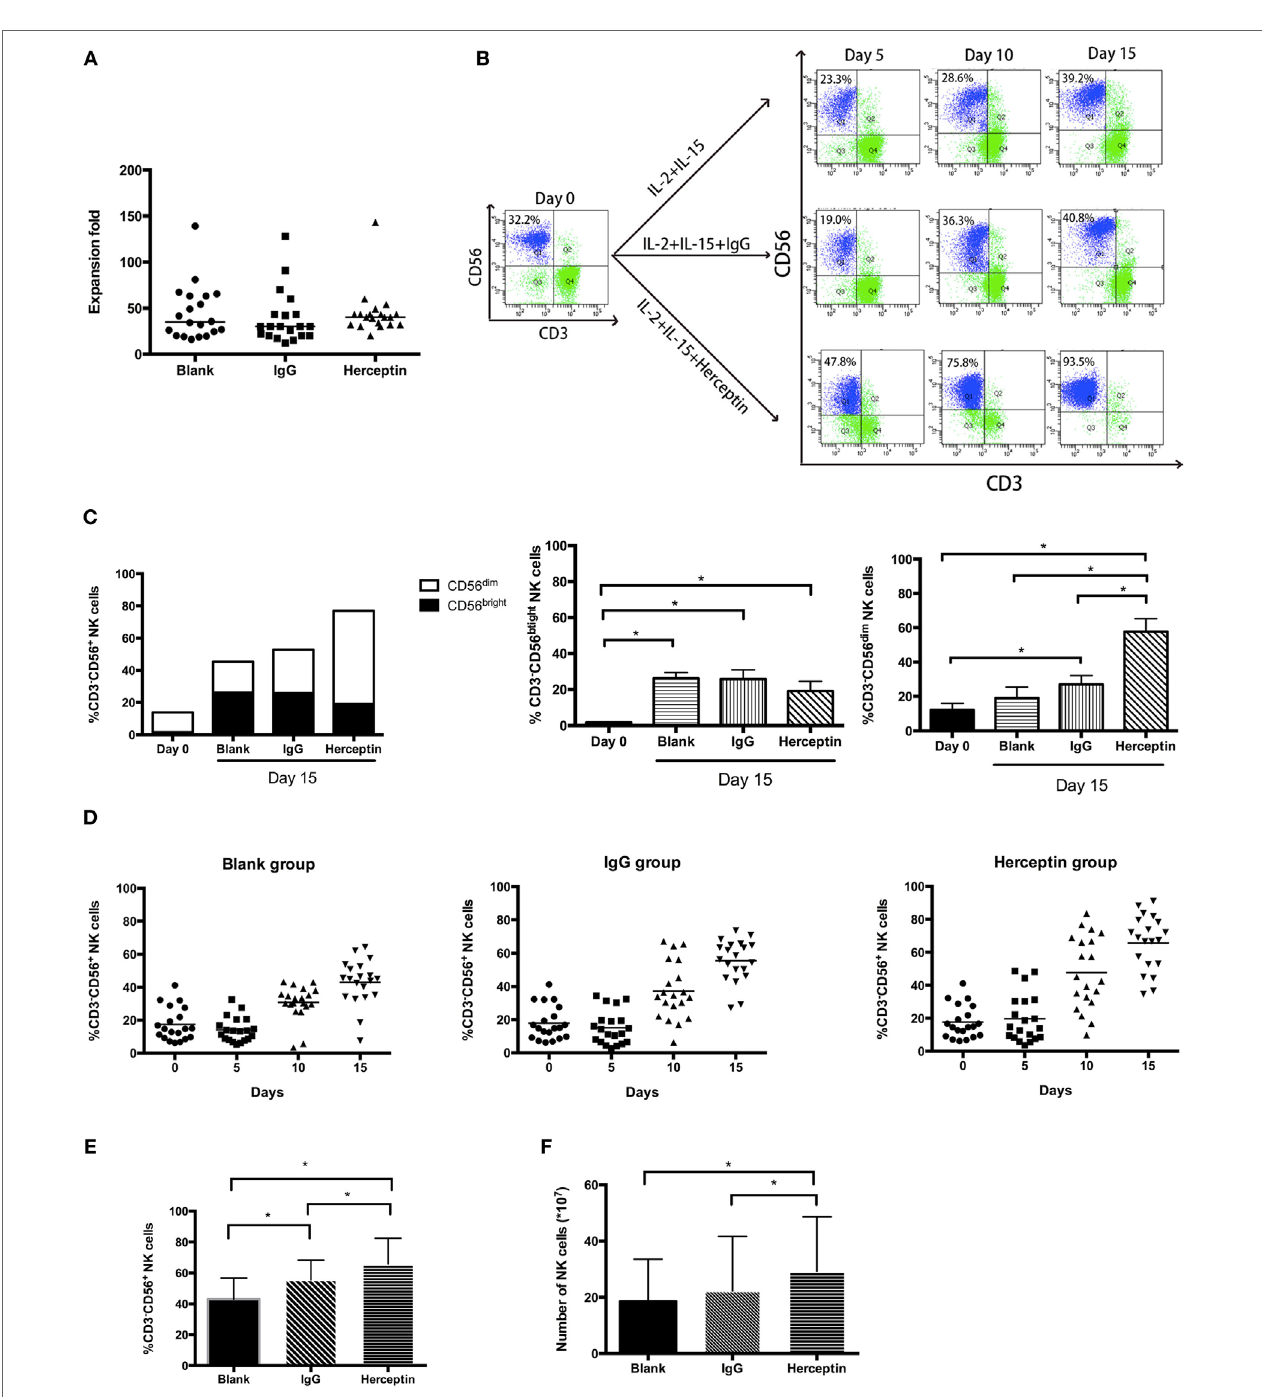
FigUre 1 | The expansion of ex vivo expanded human natural killer (NK) cells in the presence of interleukin (IL)-2 and IL-15. Freshly prepared peripheral blood mononuclear cells (PBMCs) were cultured in flasks coated with IgG1 or Herceptin for 15 days. (a) Expansion fold of the final ex vivo expanded products. We counted the cell number on Day 15 and determined the expansion fold. The results are presented as the median values for 20 patients. (B) A typical change in NK cell expansion observed among 20 samples under different culture conditions. The percentage of NK cells (CD56 + CD3 − ) in the expanded PBMCs culture was determined by flow cytometry (FCM). The left panel represents the primary PBMCs. Rows of the right nine graphs from top to bottom represent the blank group, the IgG1 group and the Herceptin group; columns from left to right represent the expansion products obtained after 5, 10, and 15 days. (c) The percentages of CD56 bright and CD56 dim subsets of NK cells. We evaluated the NK cell subsets in three samples from the three groups on Days 0 and 15. (D) Changes in the percentage of NK cells over 15 days under different culture conditions. The graphs from left to right show the blank group, the IgG1 group and the Herceptin group. (e) Percentages of NK cells in the final expansion products of three groups. (F) The number of NK cells in the three groups observed on Day 15. The results shown in (e,F) are presented as the means of 20 patients. The results are presented as the means of independent experiments, and the error bars represent the SD. * p < 0.05.